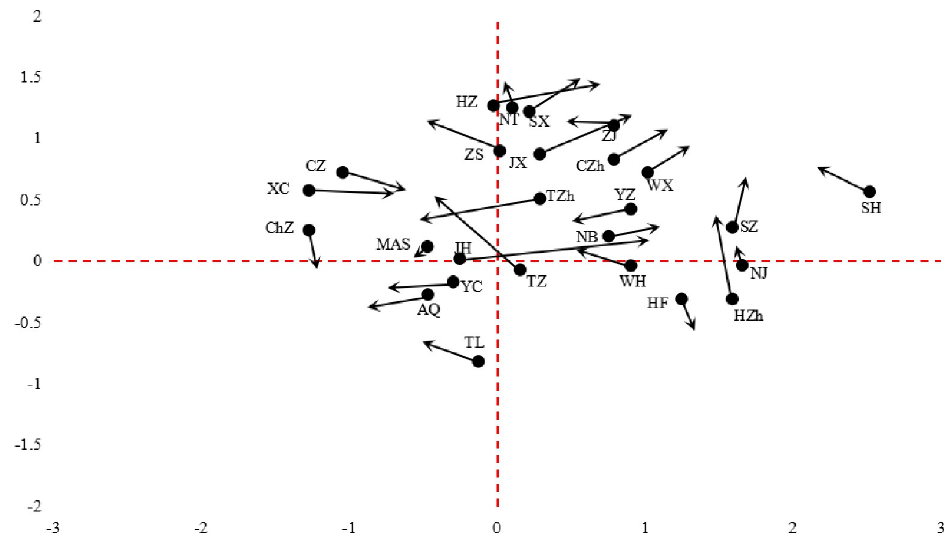
Fig 3. LISA time path movement feature of HDCT. Cities of HH type include NT, SX, ZJ, ZS , JX, CZh, SH, WX, TZh , YZ, SZ, and NB. Cities of LH type include HZ , CZ, XC, MAS, ChZ , and JH . Cities of LL type include TL, YC, and AQ. Cities of HL type include NJ , HZh , HF, WH , and TZ , and cities’ abbreviations in bold refers to these cities’ HDCT undergone time-space transitions. https://doi.org/10.1371/journal.pone.0252842.g003 whether SDM can be simplified to SEM or SLM through the Walds and LR test [50]. The test results of Wald-spatial error, Wald-spatial lag, LR-spatial error, and LR-spatial lag also passed 0.01 significance test, which means that SDM of HDCT cannot be simplified to SLM or SEM. In the end, the Hausman test results reject random effects and accept SDM with fixed effects (Table 6). In the SDM regression results of HDCT, the Log L and Adj . R 2 values of spatial fixed effect (SF) are bigger than those without fixed effect (NF), time fixed effect (TF), and space- time fixed effect (STF), indicating that the estimation results of SF should be selected for regression parameter interpretation.